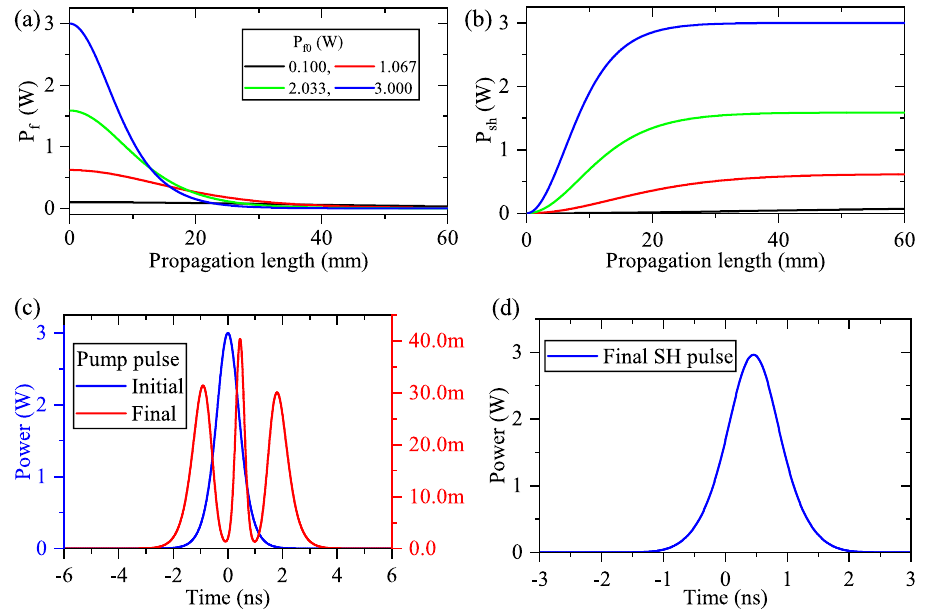
Figure 1. Optical power evolution of fundamental ( a ) and SH ( b ) modes with different values of coupled initial fundamental power, P f 0 = 0.100, 1.067, 2.033, 3.00 W, along a 60 mm homogeneous PPLN waveguide ( �β = 0 ). For high input power, fundamental mode depletes in a shorter propagation length to generate the SH one. ( c ) Initial (blue- without depletion) and final (red- with depletion) shapes of fundamental pulse in the pulsed-SHG process for the same waveguide (L = 60 mm) and P f 0 = 3.00 W peak power. Because of the power- dependent depletion of the fundamental mode, its final shape changes from the initial sech shape of the generated SH pulse. Since the generation rate of the SH mode is always positive, SH pulse maintains 2 the sech shape with a narrower